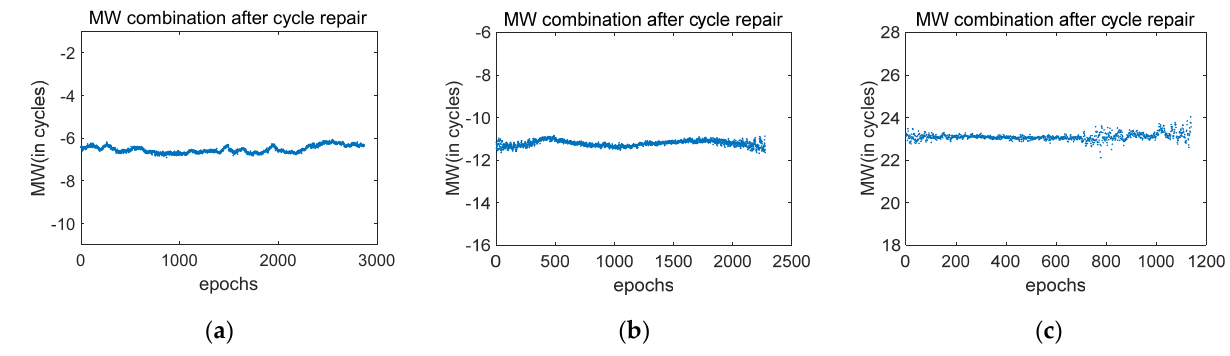
Figure 5. MW combination values after cycle slips were repaired.